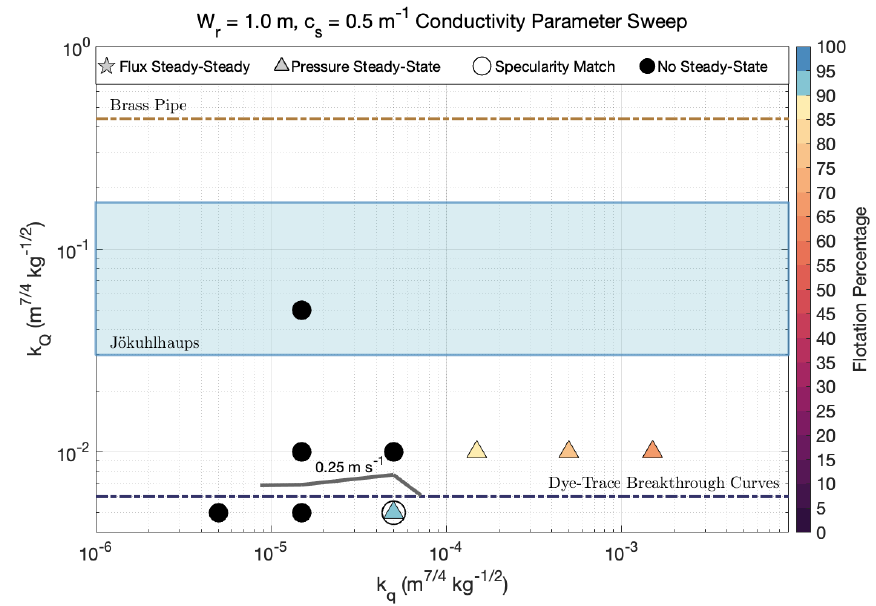
Figure A5. Same as Fig. 4 but for bed roughness parameters W r = 1 . 0m and c s = 0 . 5m − 1 .